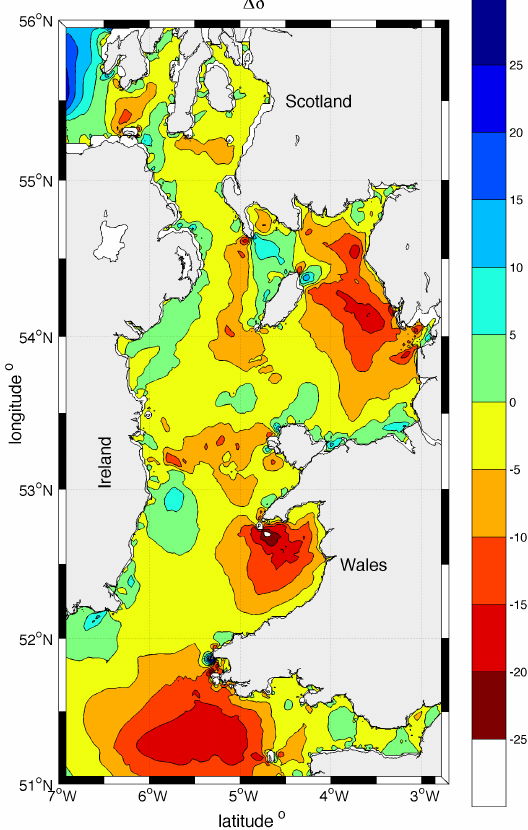
Fig. 6. Difference between the rotational–oscillating and oscillating bottom boundary layer in the Irish Sea. Negative values suggest that the boundary layer is overpredicted by the non-rotational boundary layer.